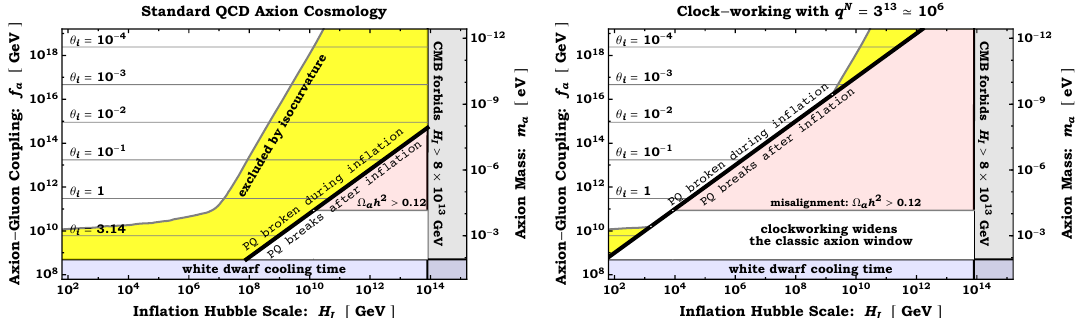
Figure 5 . The canonical parameter space of QCD axion cosmology (left), and how this parameter space is modi(cid:12)ed due to the clockworking (right). In the right panel we (cid:12)x the clockworking factor, q N , and vary f pq f a =q N . The diagonal boundary corresponds to f pq H I = 2 (cid:25) . Clockworking (cid:24) (cid:24) widens the classic axion window, f a (10 9 ; 10 11 ) GeV, allowing lower H I . The various shaded 2 regions are excluded: the yellow region is excluded by CMB limits on isocurvature [11]; the blue region is excluded by limits on white dwarf cooling time [9] (observations constrain the axion-photon and axion-electron couplings, and the mapping to axion-gluon coupling is model-dependent); the gray region is excluded by CMB limits on in(cid:13)ationary gravitational waves ( r < 0 : 1) [47]; and the red region is excluded by measurements of the dark matter relic abundance (assuming the axion is cosmologically